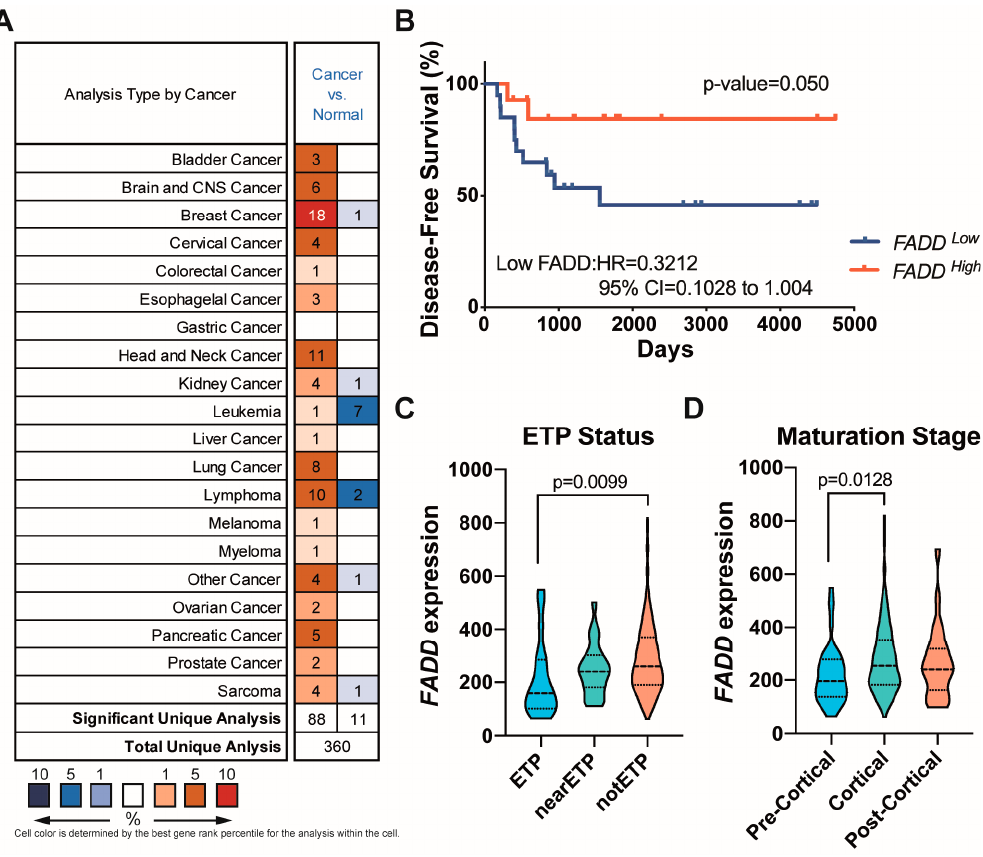
Figure 1. Reduced FADD levels associated with poor prognosis in precursor T-cell neoplasms . ( A ) Analysis of FADD expression in cancer types. The gene summary for FADD in cancers was gained